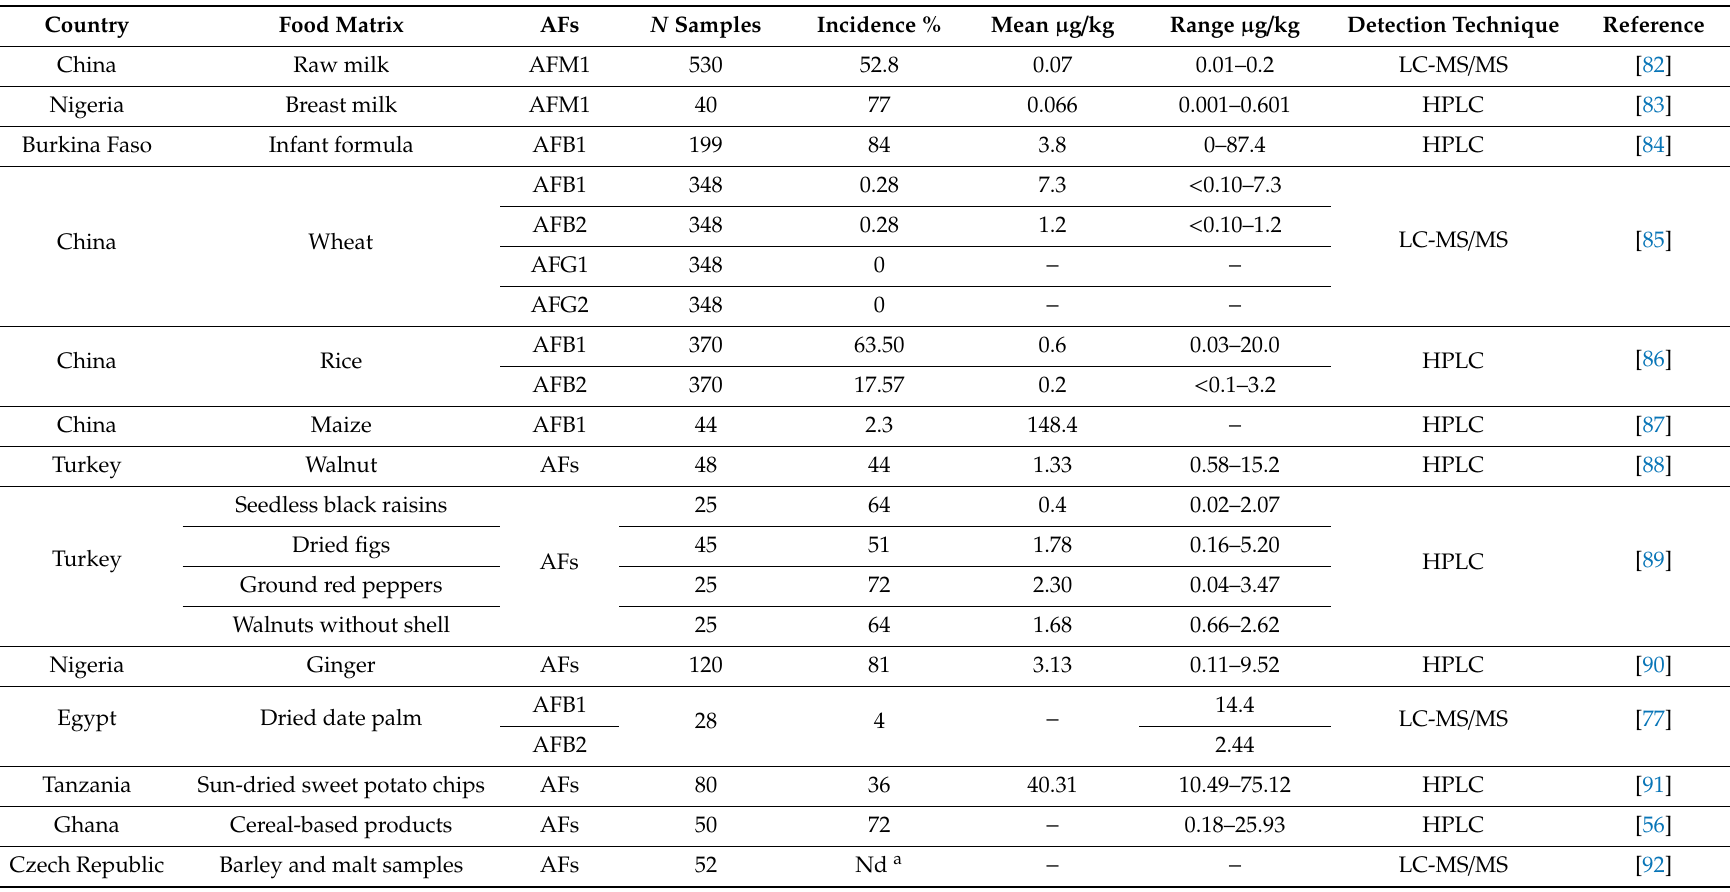
Table 4. Representative studies on the occurrence of aflatoxin (AF) distribution ( µ g / kg) in food samples around the world during 2014–2019.